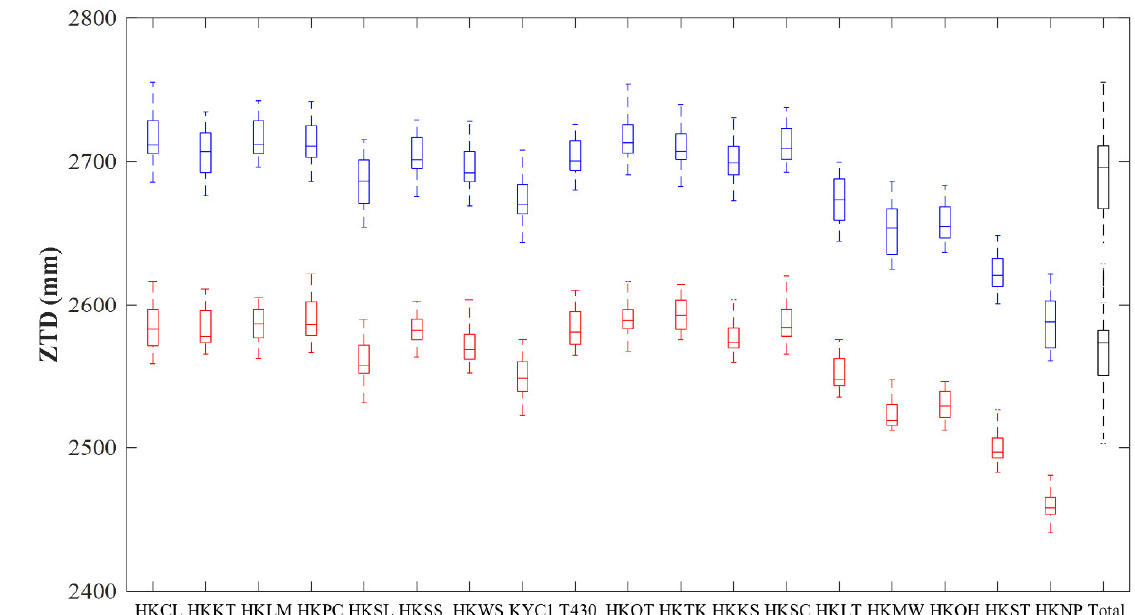
Figure 11. Box and Whisker of the observed ZTD in each site during the period of rainless and rainy days. Blue for the rainy conditions and red for the rainless conditions, and black for the combination of the two weather conditions.